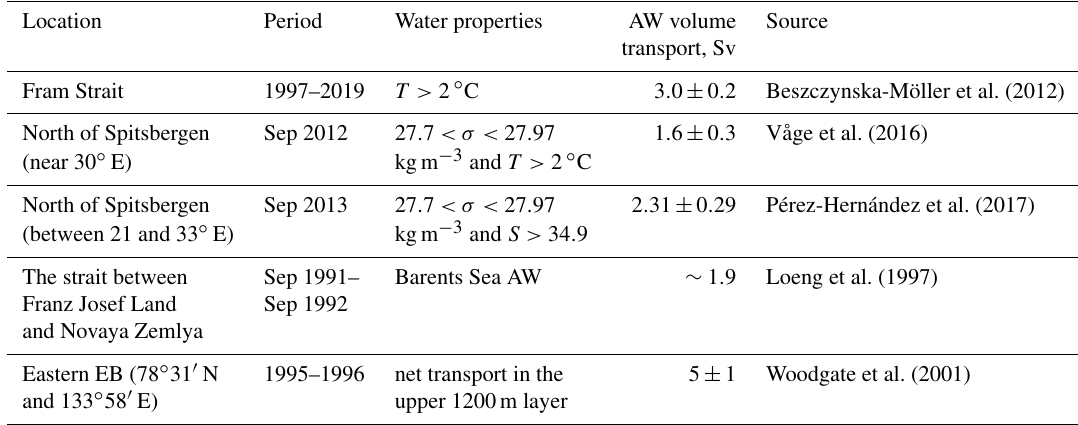
Table 1. Estimates of volume transport in the Eurasian Basin of the Arctic